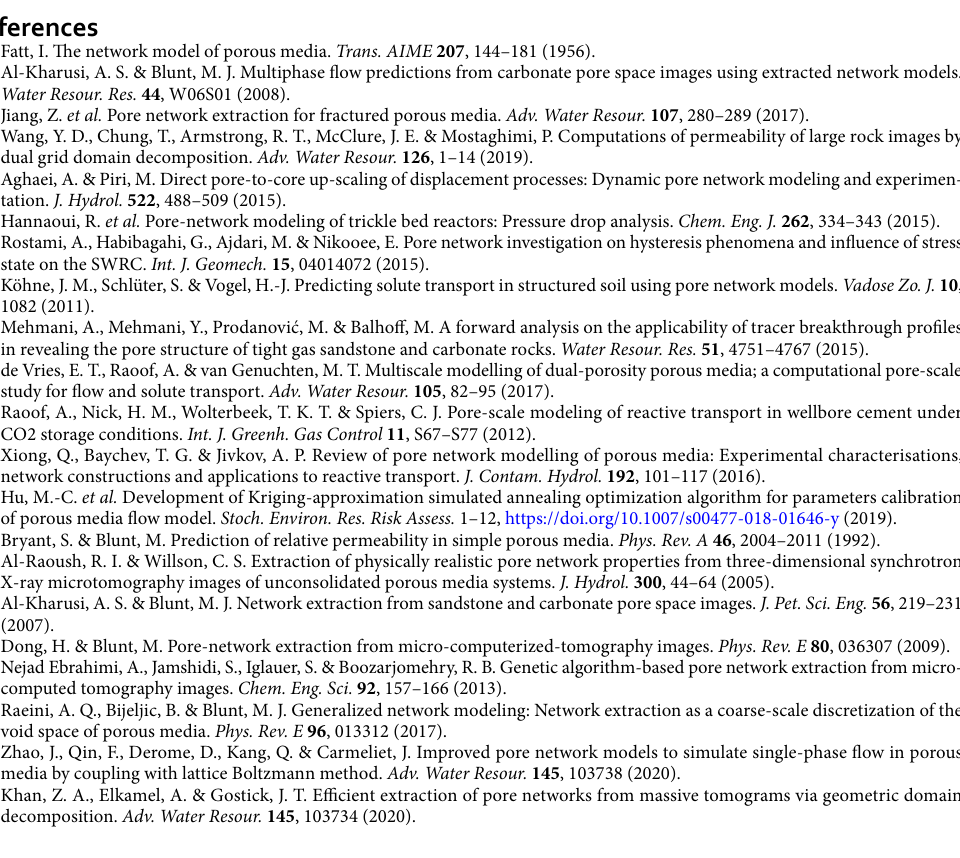
distributed streamlines were seeded on the input patch, which were then propagated according to the velocity field (see Fig. 11). Finally, after discarding the parts of the streamlines that lay outside of the porous medium related mesh (i.e., in the areas next to input and output patches), the tortuosity value of the sample was estimated as the average of the tortuosities of the streamlines.